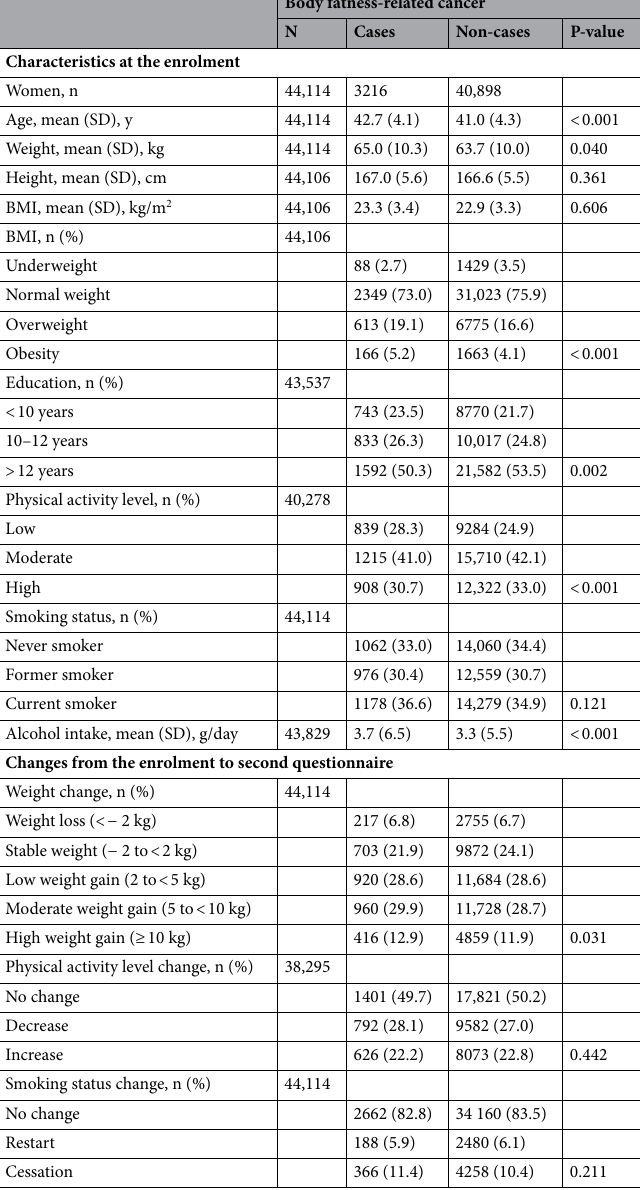
Table 1. Population characteristics of participants according to diagnosis of body fatness-related cancer. BMI body mass index, SD standard